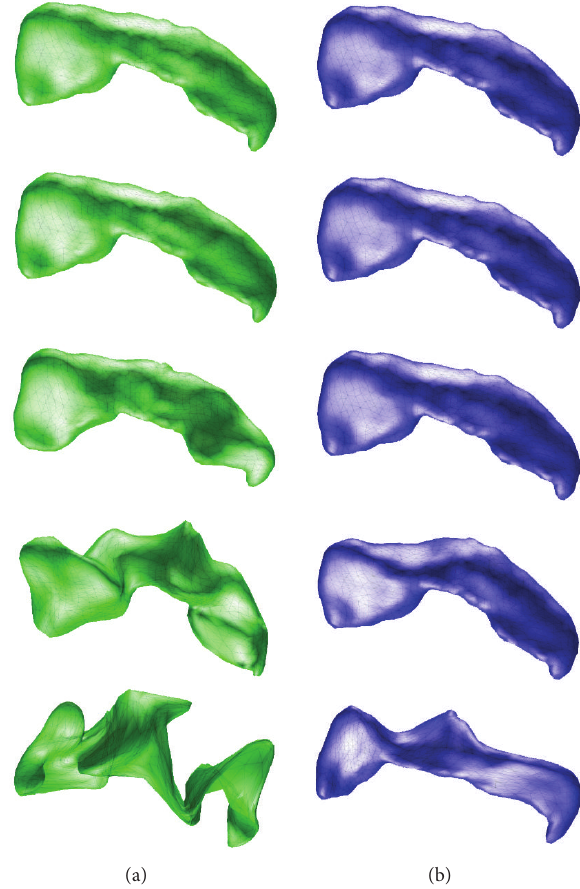
Figure 11: Example result from simulated data. (a) Standard land- mark matching, (b) GDAS landmark matching. Landmark variance from top to bottom: 0.004475, 0.04475, 0.4475, 4.475, and 44.75.